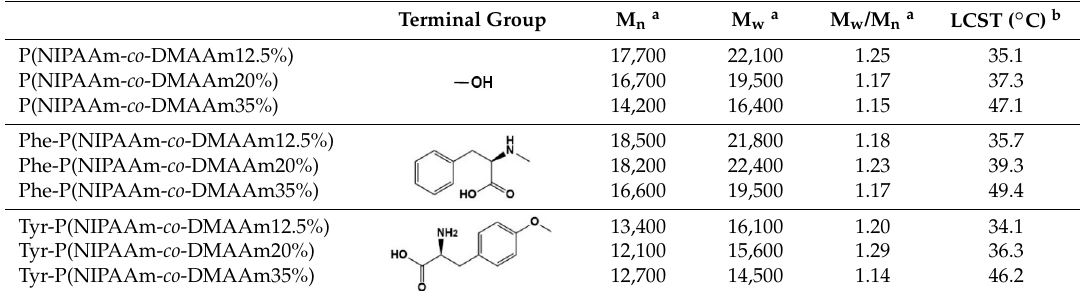
Table 1. Polymer characterization.